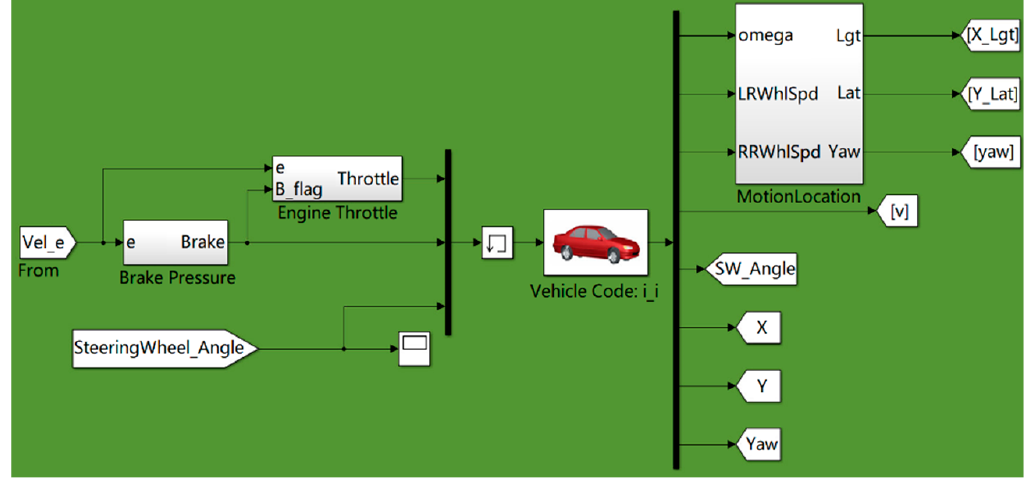
Figure 14. Rear Axle Midpoint Coordinate Output Module.